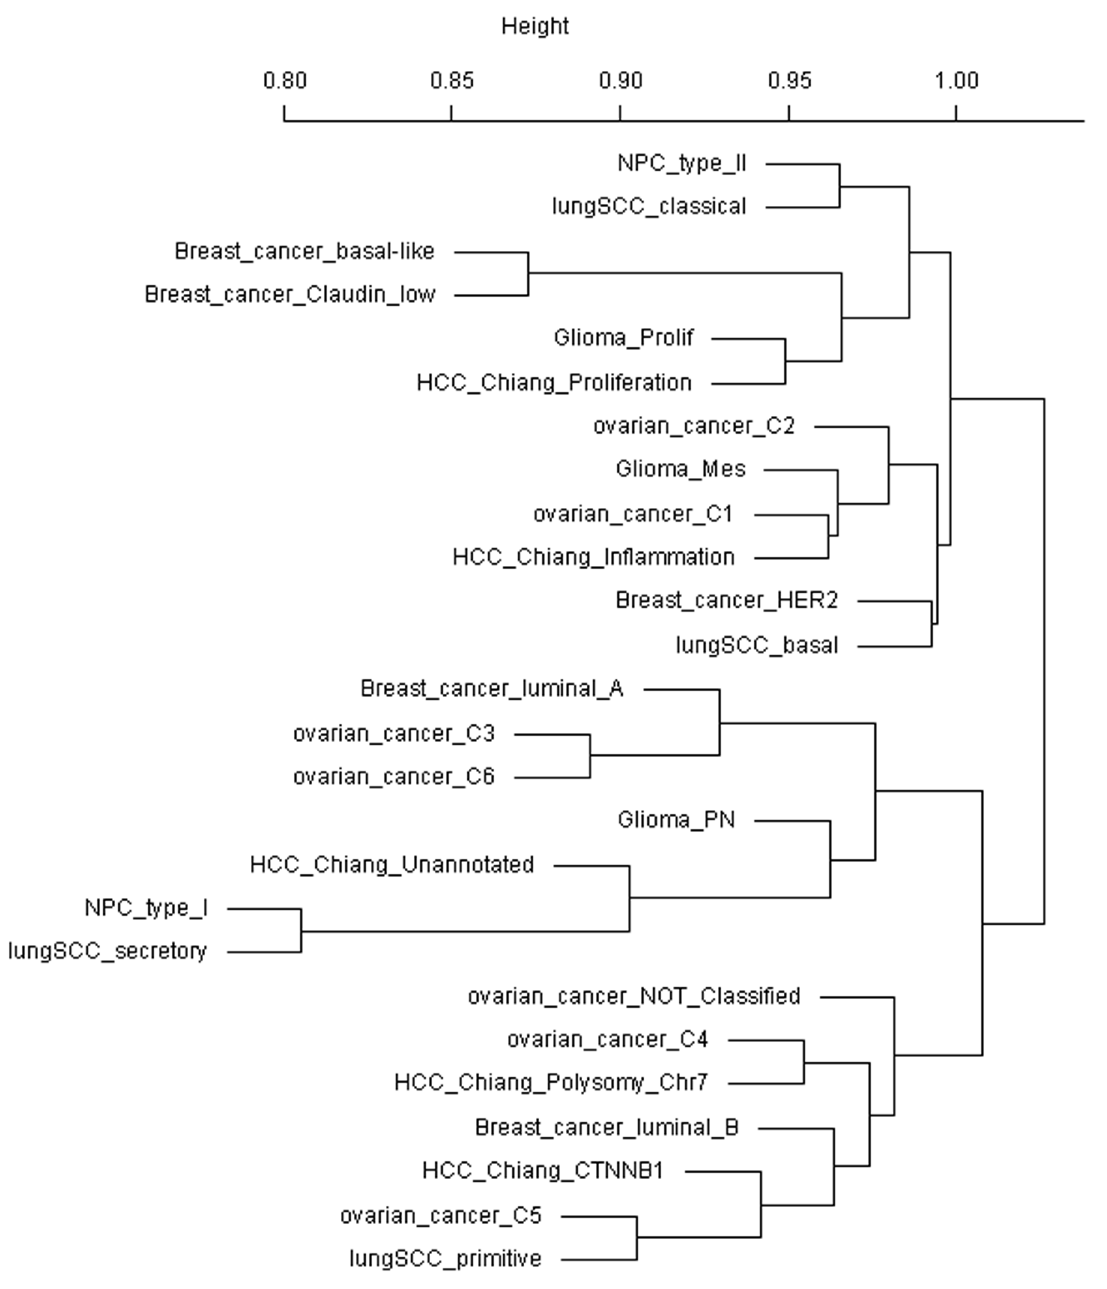
Figure 2. Phylogeny of cancer subtypes. . The median of spearman rank correlation of transcriptional profile between two subtypes was minus by 1 and then adopted as the dissimilarity distance. Calculation of tumor phylogeny was then done by applying average linkage clustering in